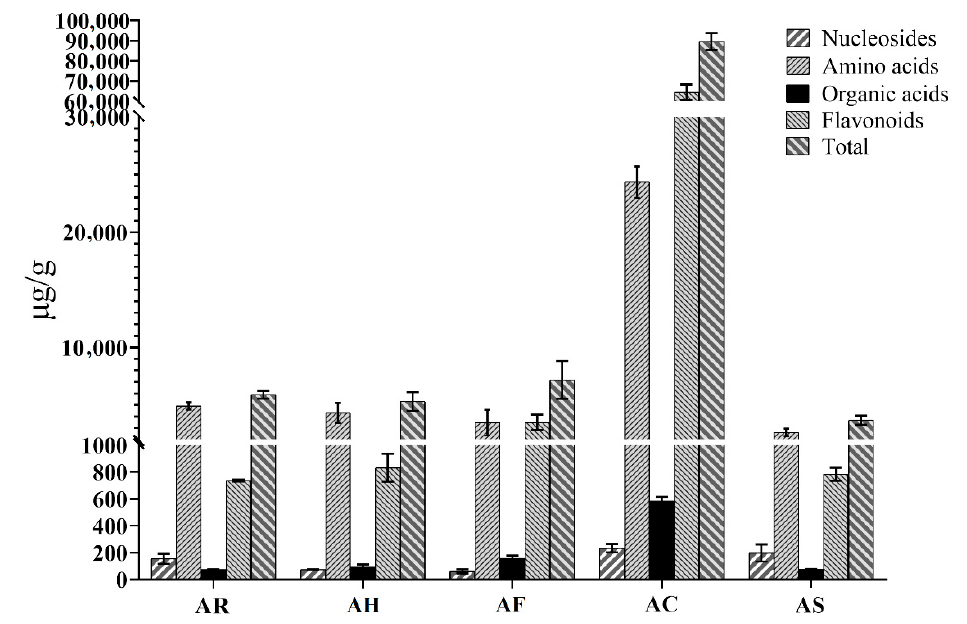
Figure 2. The content of four types of constituents in different parts of Abelmoschus manihot .